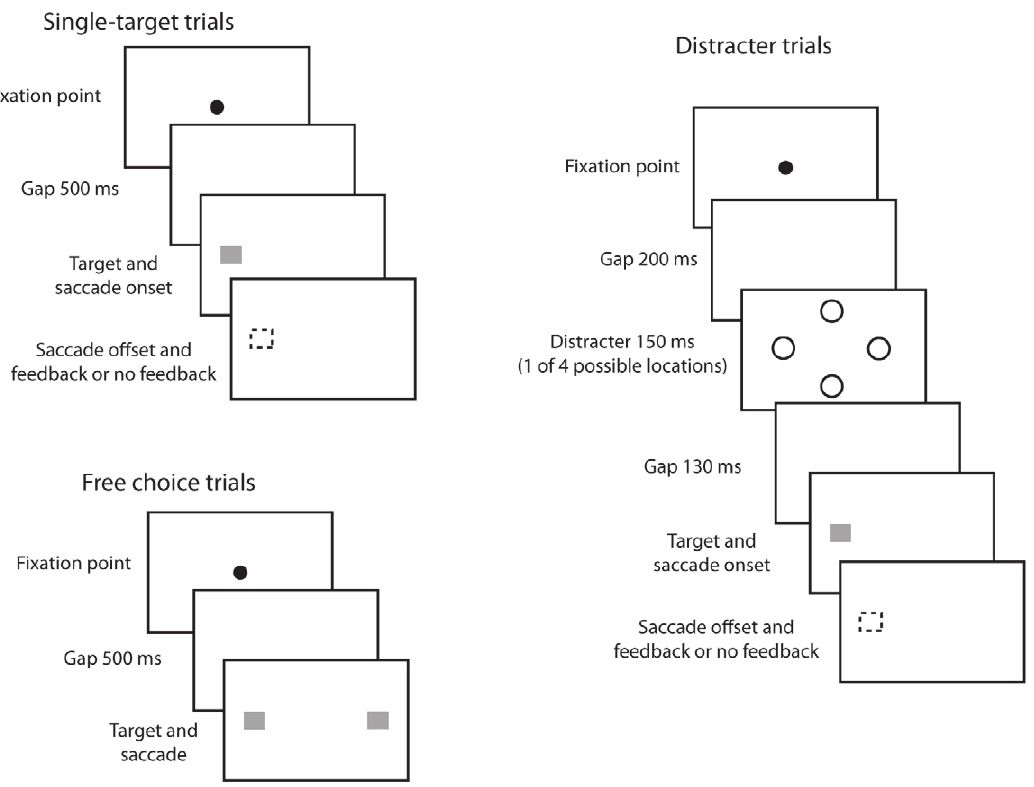
Figure 1. Procedure. Single-target and free choice trials: After successful fixation, a 500 ms gap was followed by presentation of one or two targets (single-target and free choice, respectively). Subjects had to saccade to (one of) the target(s). In the single-target trials, at saccade onset the target disappeared or remained visible depending on side and feedback condition. Distracter trials: After successful fixation, a 200 ms gap preceded the brief presentation of a distracter at one of four equiprobable locations. If an erroneous saccade to the distracter occurred, the trial was aborted. Otherwise, 130 ms after the distracter, a target appeared to the left or right and was extinguished or remained visible upon saccade onset, depending on side and feedback condition.